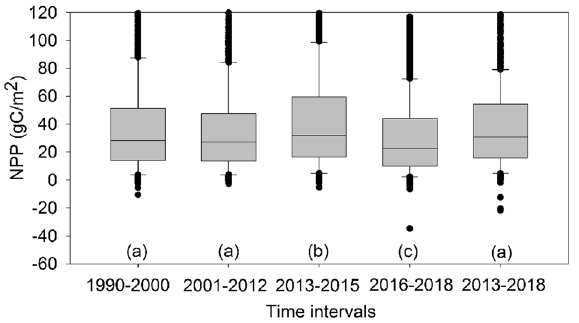
Figure 2. Mean NPP at three time intervals. Letters represent significant differences in mean NPP at the 0.05 significance level.